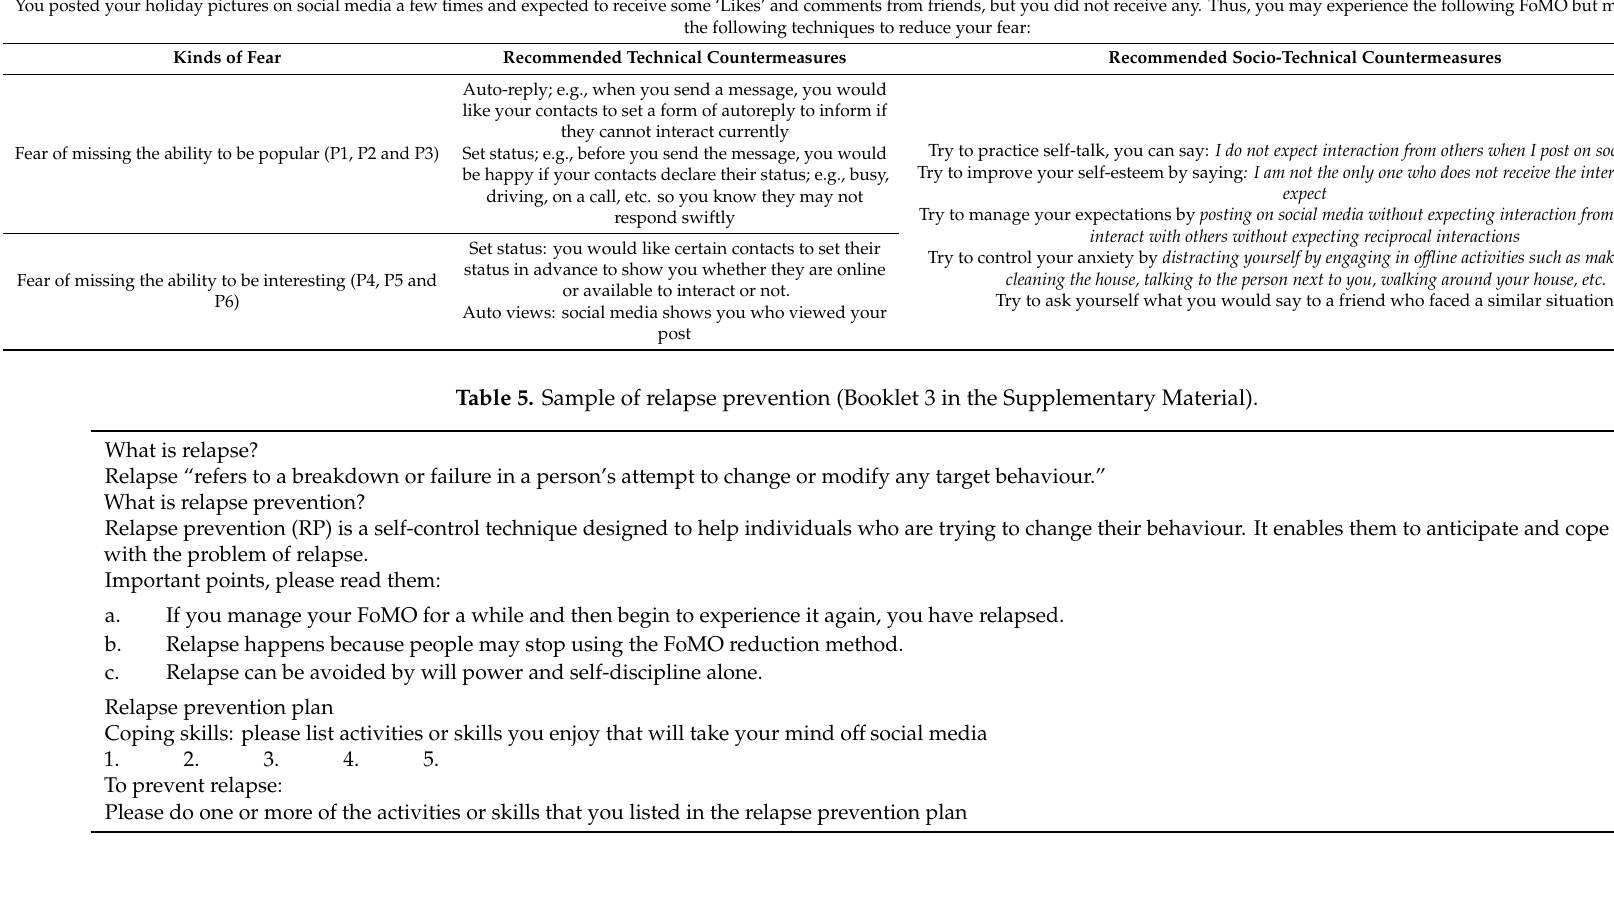
Table 4. Sample of FoMO countermeasures for Context 1 (Booklet 2 in the Supplementary Material). Context 1: FoMO When Others Do Not Interact as Expected